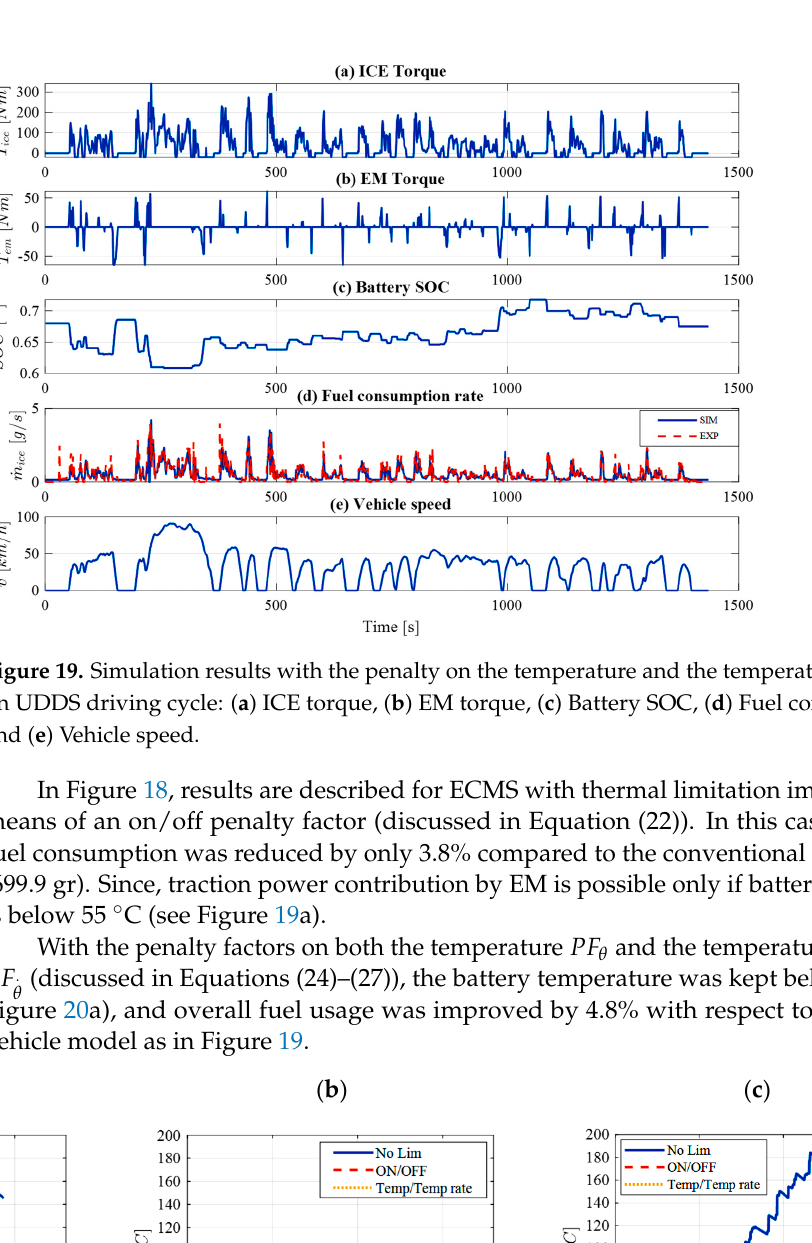
Figure 20. The battery temperature for different temperature limitation strategies and driving cy- cles: ( a ) UDDS; ( b ) NEDC; and ( c ) WLTC. Blue, solid line—No thermal limitation; Orange, dashed line—on/off temperature control; Yellow, dotted line—Temperature and temperature change rate limitation.